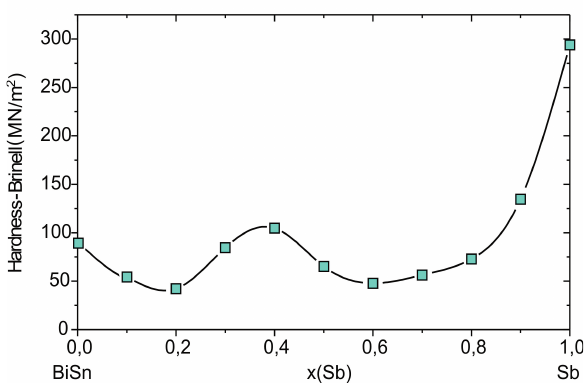
Figure 2. Hardness of alloys of ternary Bi-Sb-Sn system, vertical BiSn-Sb section.